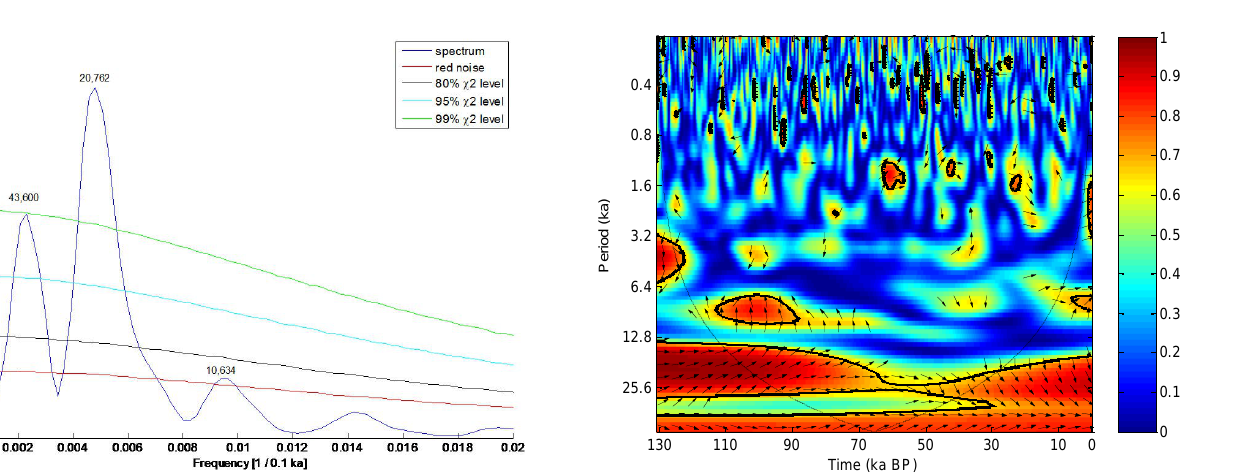
Fig. 4. Power spectrum of the non-smoothed Guliya δ 18 O- temperature proxy record with 1308 samples.